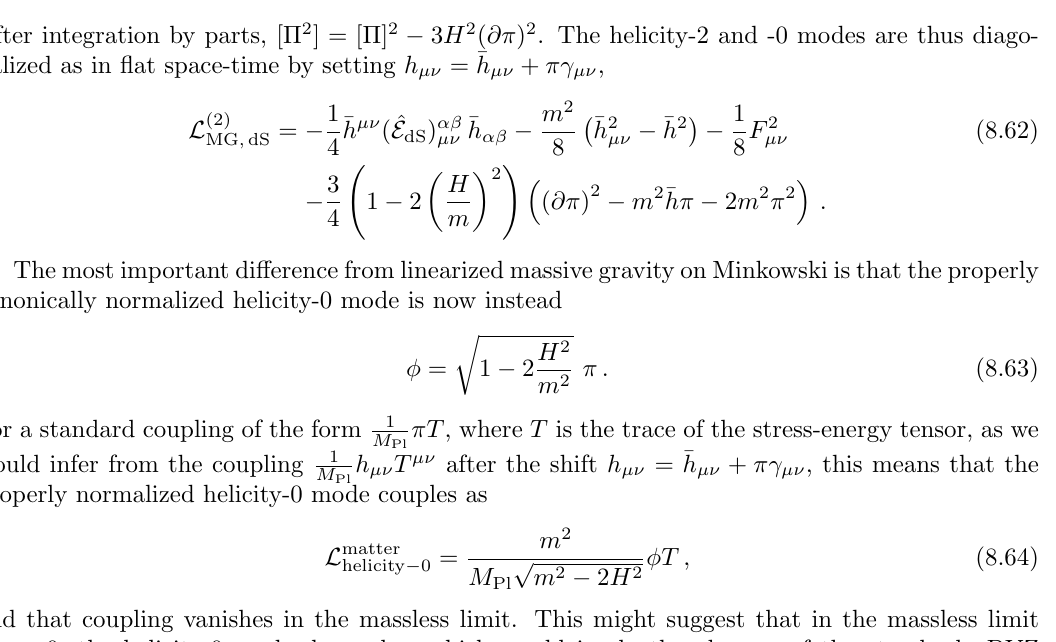
Living Reviews in